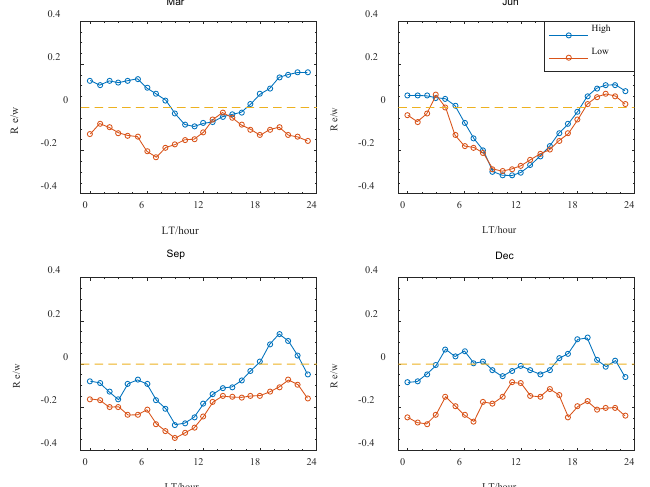
Figure 5. Local time variations of the east-to-west differential index R e/w in spring, summer, autumn and winter in high and low solar activity years.